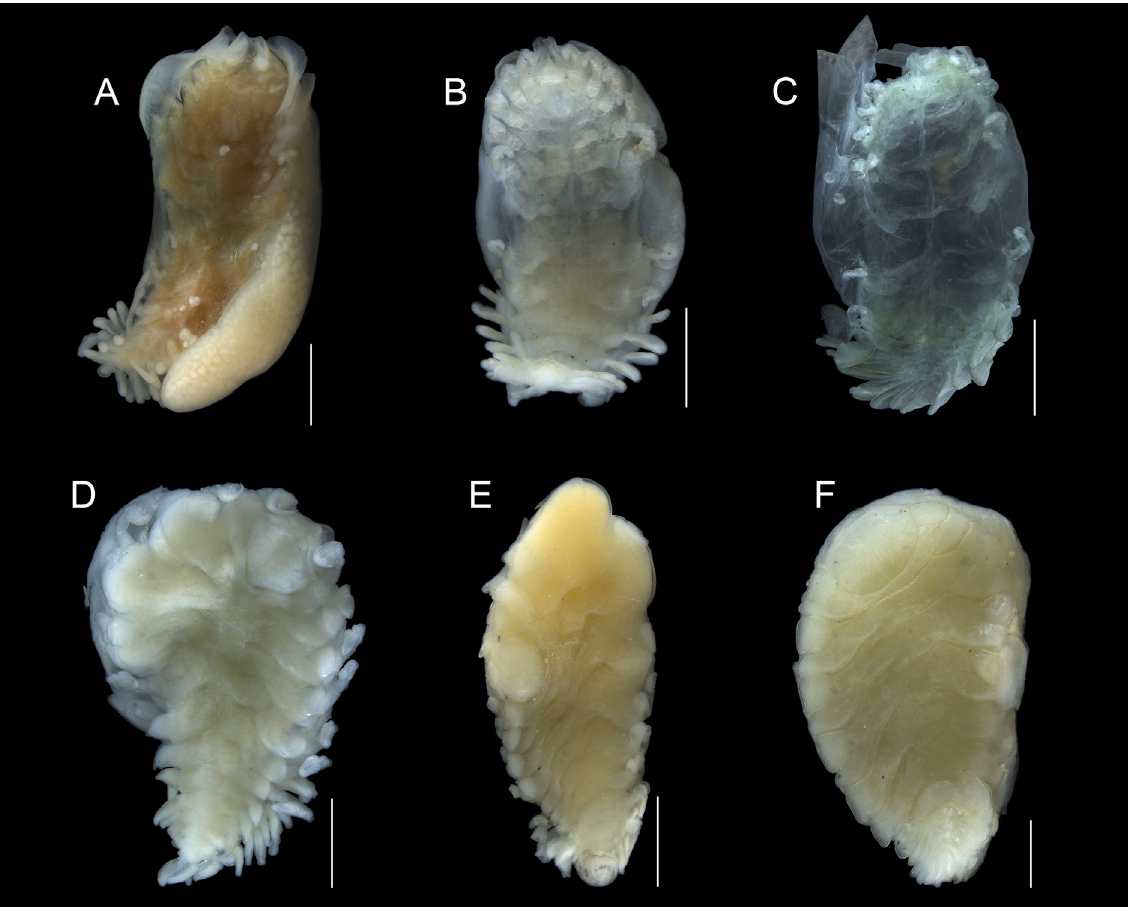
Fig. 2. Dorsal view of ovigerous females of bopyrid isopods that parasites hermit crabs in Atlantic Mexican coasts. A . Anathelges hyptius (Thompson, 1902) (CNCR-36525-C). B . Pseudostegias